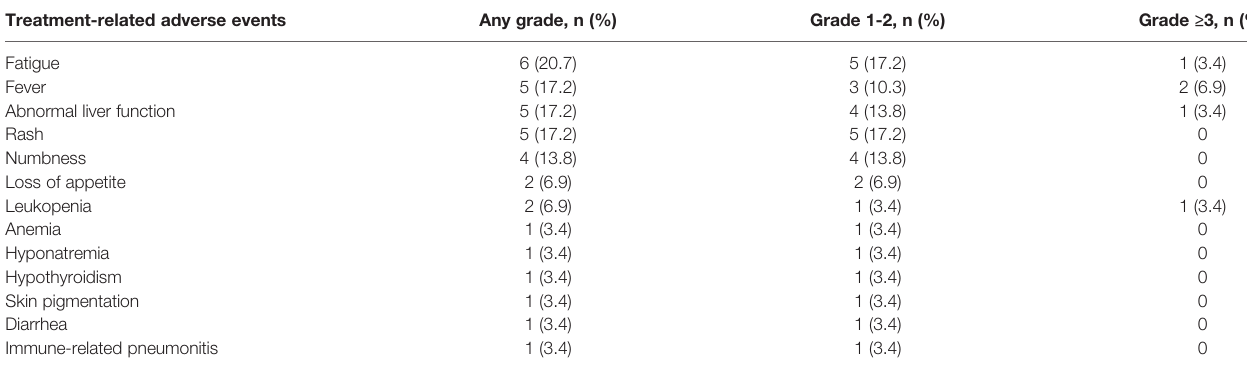
TABLE 3 | Incidence of treatment-related adverse events. Treatment-related adverse events Any grade, n (%)